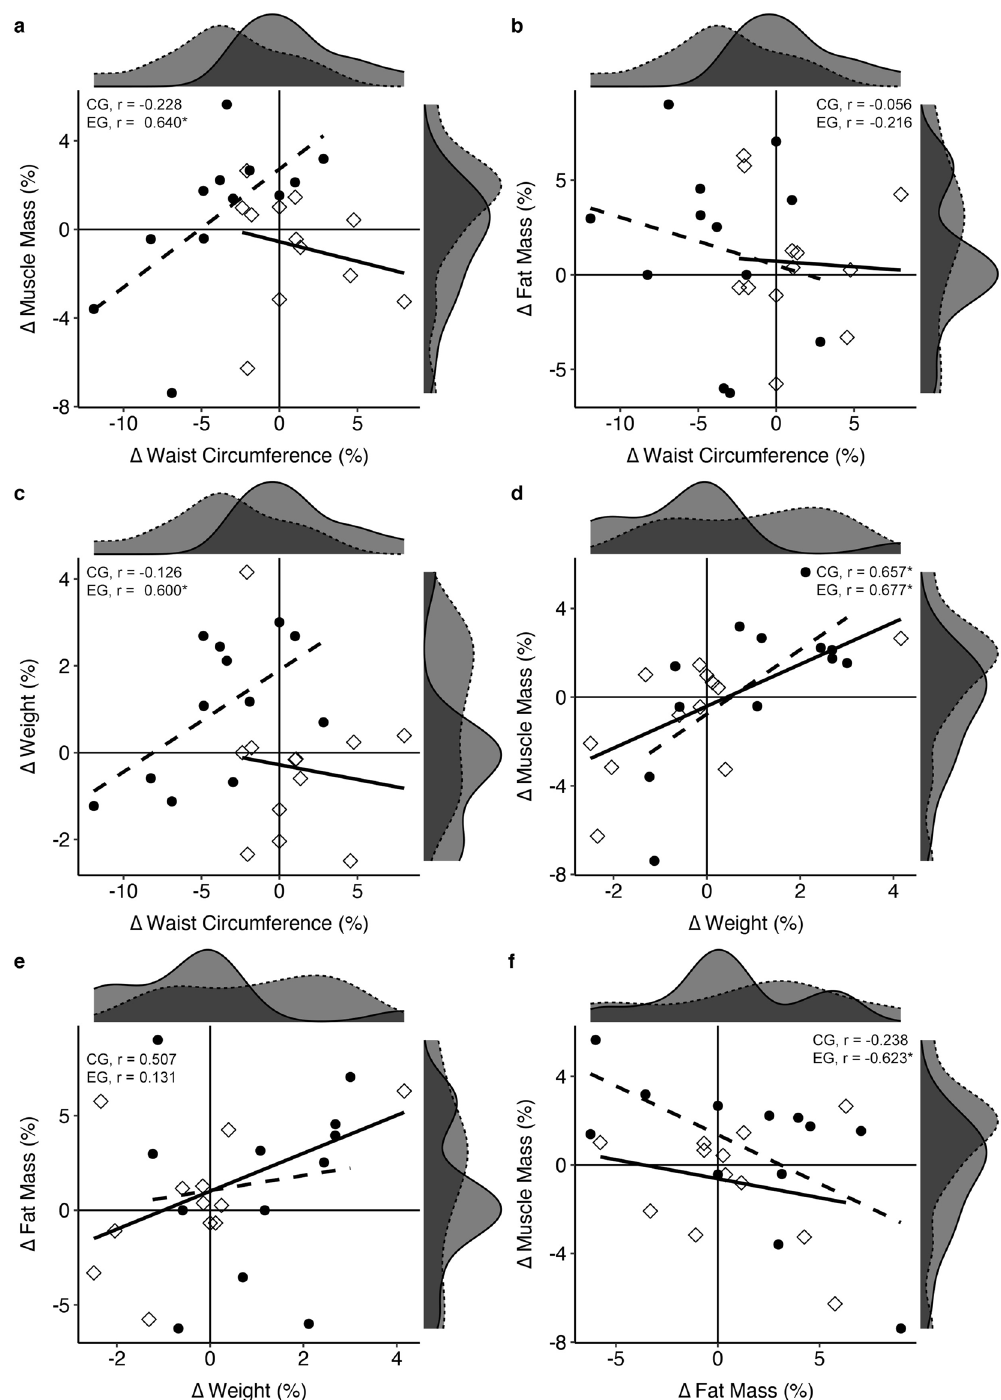
Figure 2. Pearson correlations between percentage changes in body composition variables. Changes in the control group (CG) are represented by a solid line, diamond points, and solid line density plot. Changes in the exercise group (EG) are represented by a long-dashed line, filled circle points, and a dashed line density plot. Significance: * p < 0.05, ** p < 0.01, *** p <